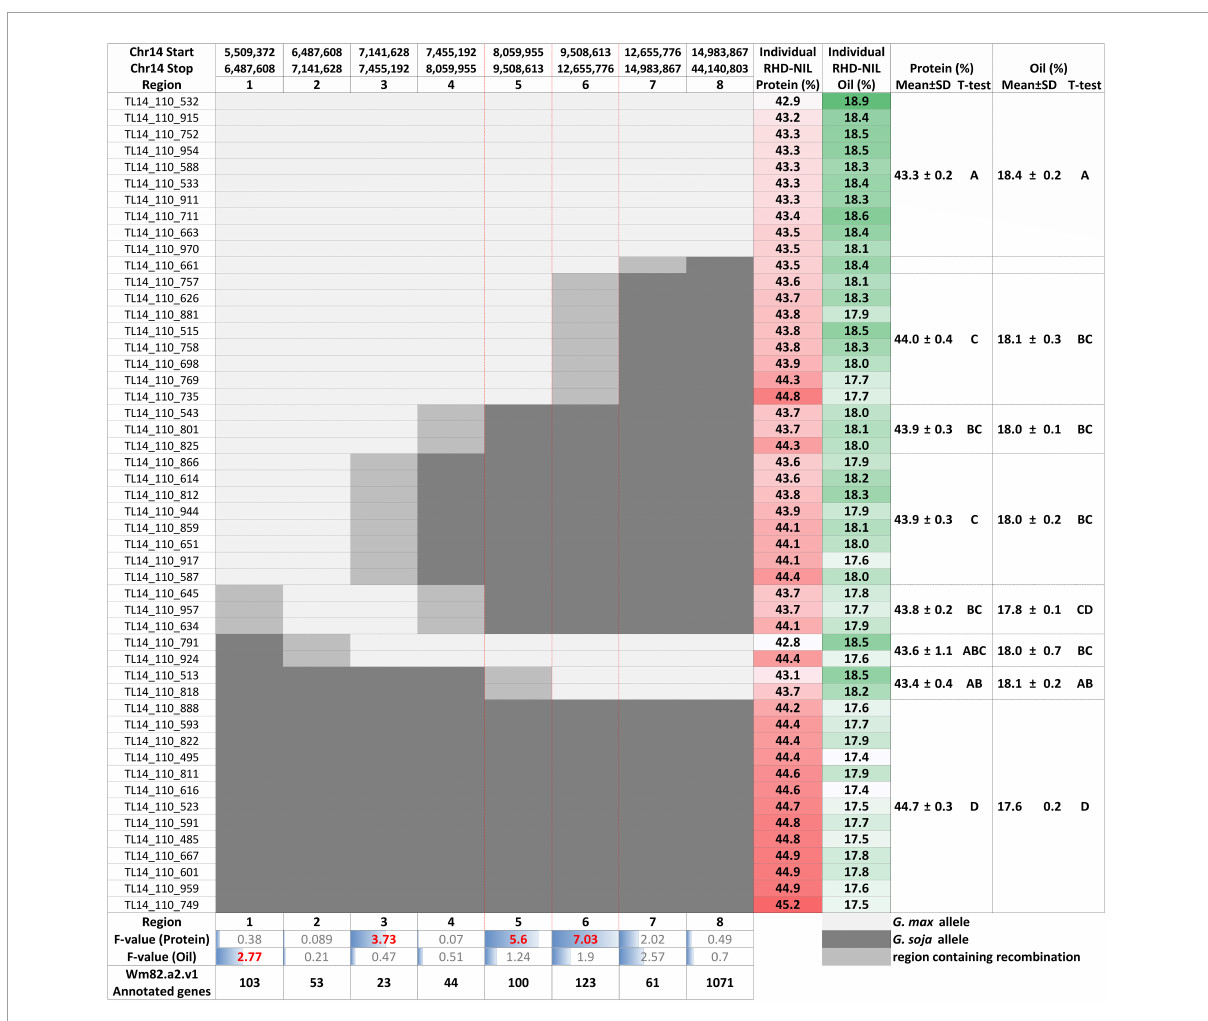
FIGURE4 Individual RHD-NILs and their eight recombination regions with the physical start and stop positions, protein and oil content, and the mean with the standard deviation (SD) based on their t -test grouping. F -value for the protein and oil content and the number of Wm82.a2.v1 annotated genes are displayed at the bottom. G. max are white, G. soja are dark gray, and the region containing recombination is light gray. Regions 5 and 6 are outlined in red to showcase the most significant regions for seed protein